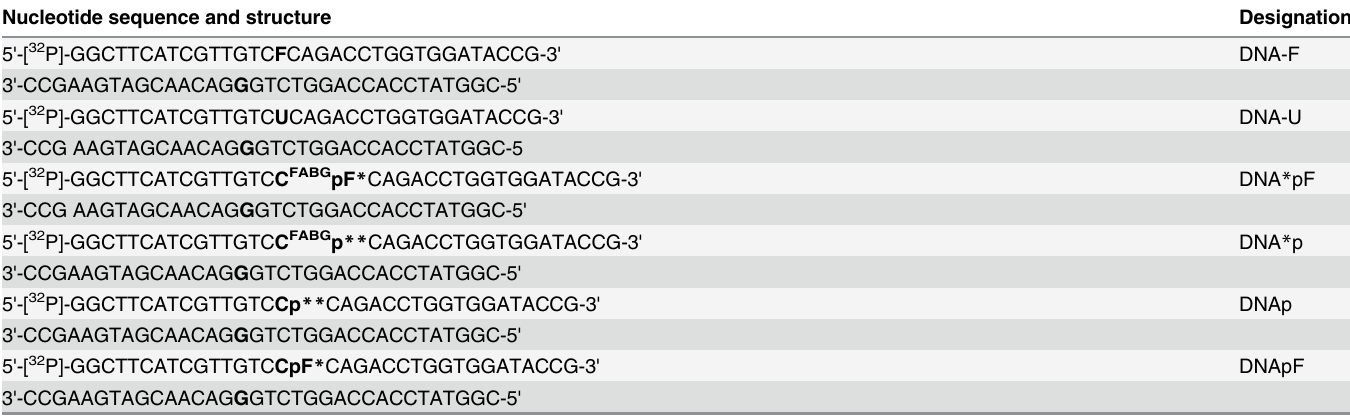
Table 1. Nucleotide sequences, designations and structures of DNA substrates used for photocrosslinking and assay for PARP1 autoPARylation. Nucleotide sequence and